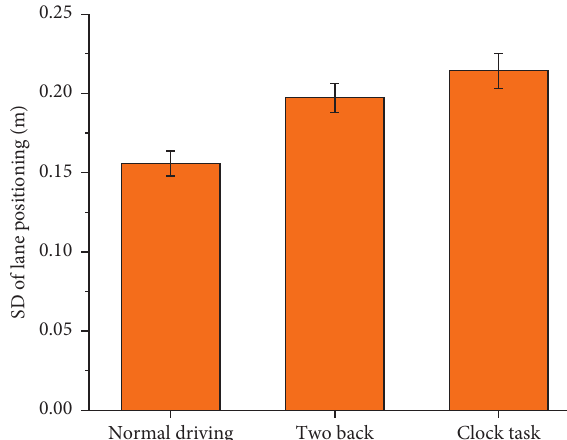
Figure 13: Main effect of the driving tasks on the SDLP.